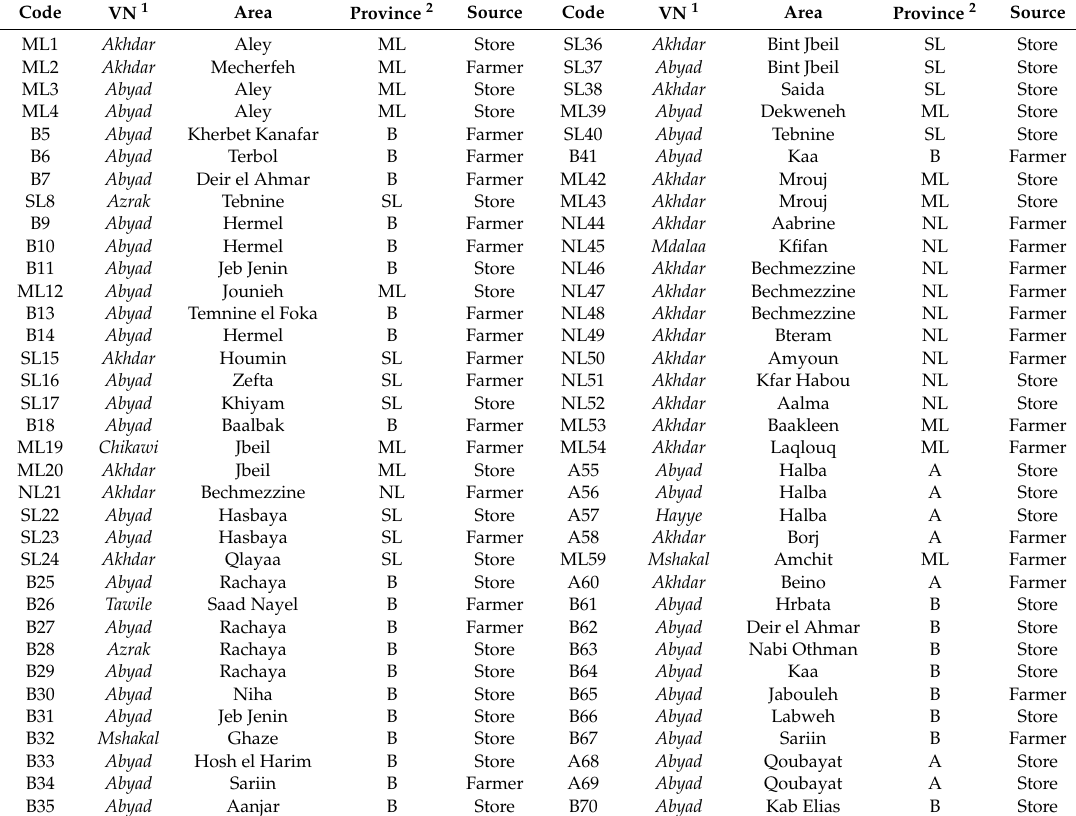
Table 2. Morphological traits recorded in the Lebanese snake melon accessions.